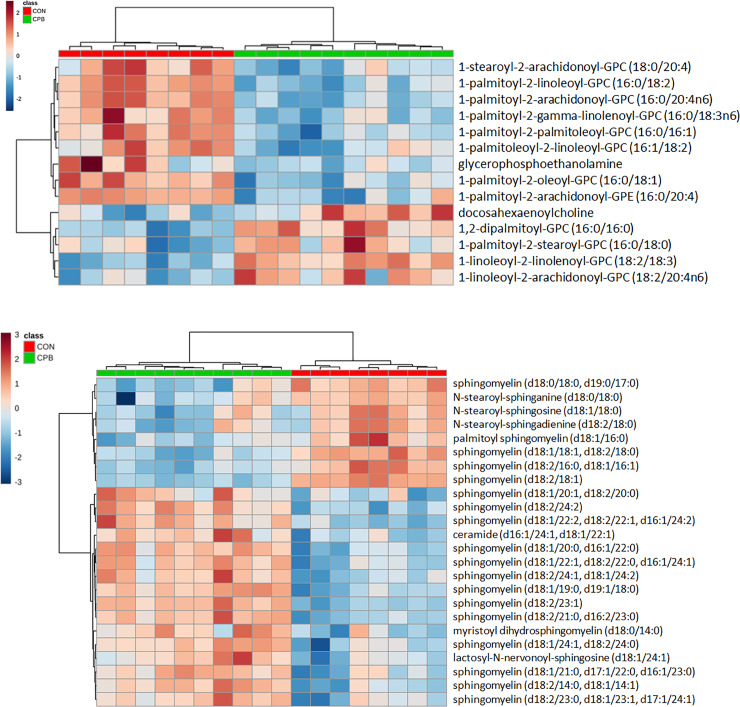
Heatmaps of changes of phospholipids (A) and sphingomyelins (B) from baseline to 6 months. Legends: diet groups are represented by red (CON) and green (CPB) boxes on the top of the heatmaps; Keys: orange indicates increases while blue indicates decreases from baseline.